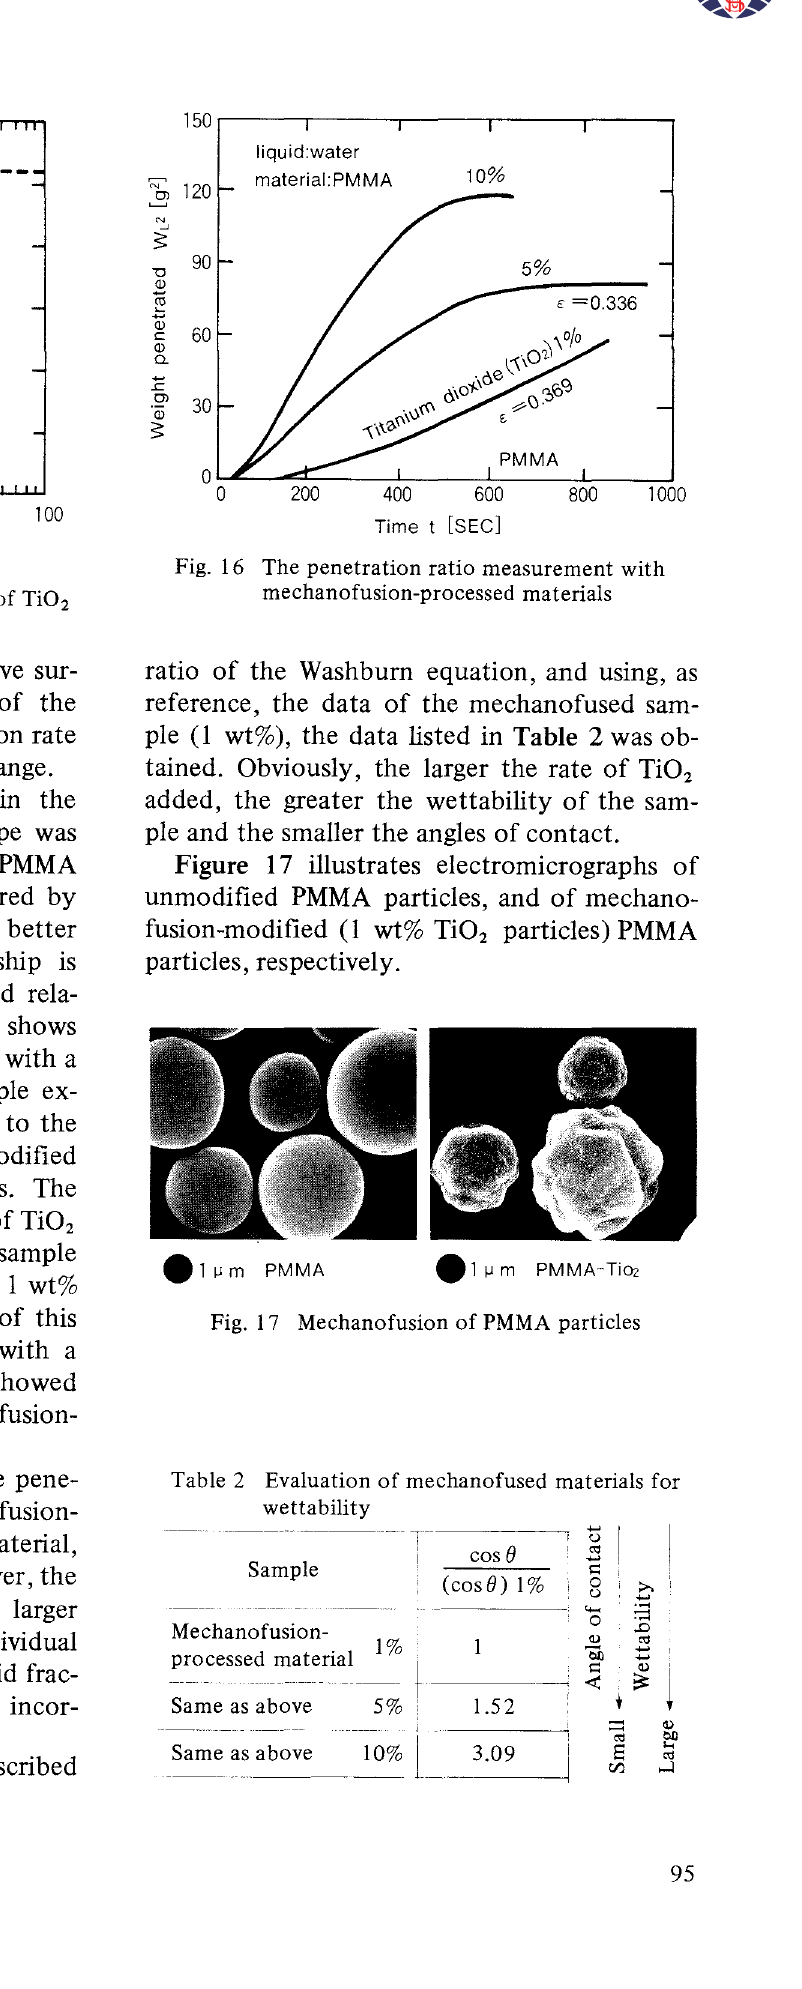
Table 2 Evaluation of mechanofused materials